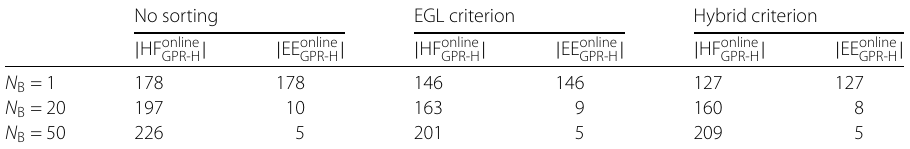
Table 2 Comparison of the number of online high fidelity evaluations | HF online | for the GPR-Hybrid approach with different updating strategies evaluations | EE online GPR-H No